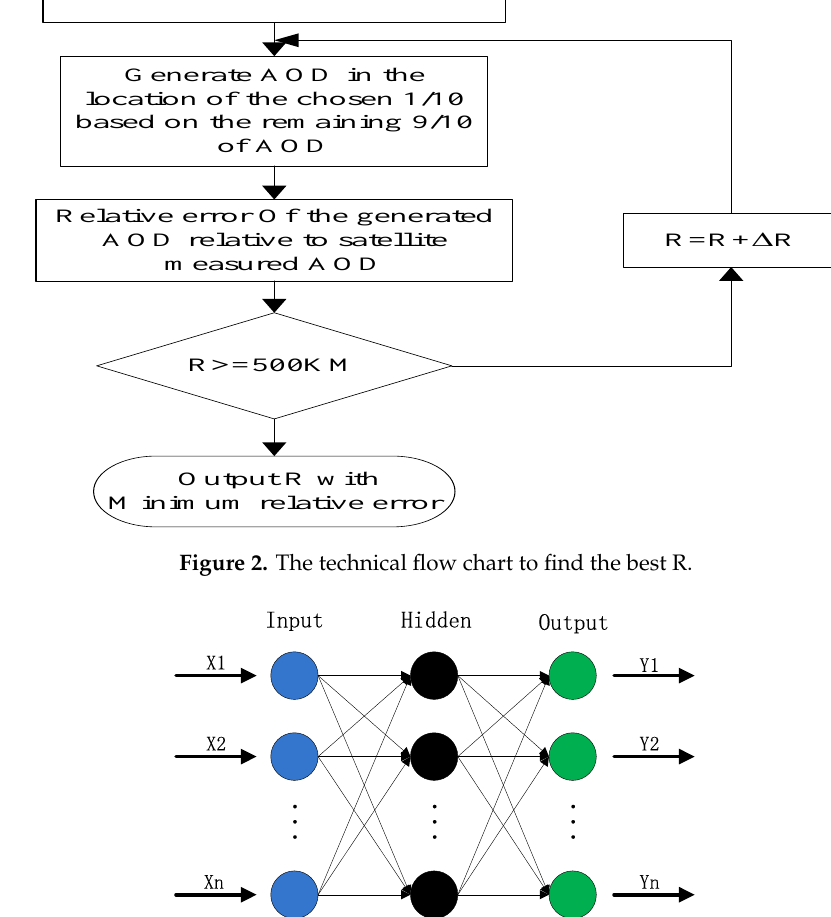
Figure 3. Topological structure of the back propagation (BP) network, which includes only one layer of the hidden layer.